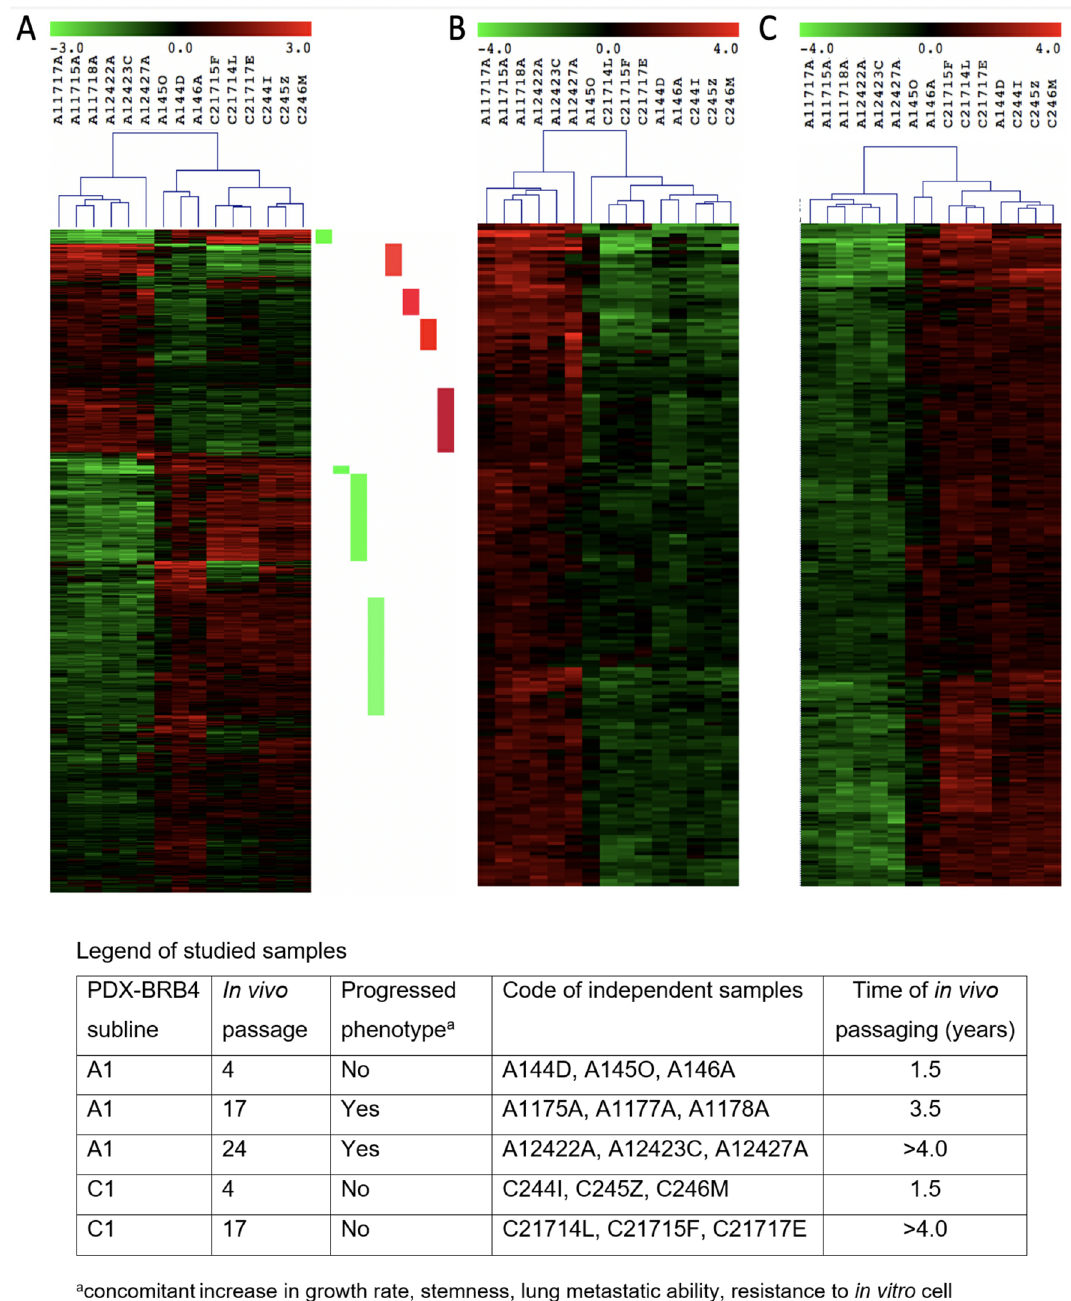
Figure 6. Hierarchical clustering (Euclidean distance, average linkage) of differentially expressed genes in progressed subline (see Legend Table enclosed for codes of independent samples examined along with their progression phenotypes). ( A ) 834 DE genes detected comparing progressed (passage 17) with non- progressed (passage 4) A1 subline of PDX-BRB4. Red and green lateral bars indicate the gene subsets showing homogeneous progressed phenotype (passages 17 and 24) with respect to non-progressed low-passage 4 (either subline) or 17 (C1 subline). ( B ) 193 DE genes up-modulated in progressed A1 subline (passage 17 and 24, see red bars of panel A ). ( C ) 288 DE genes down-modulated in progressed A1 subline (passage 17 and 24, see green bars of panel A